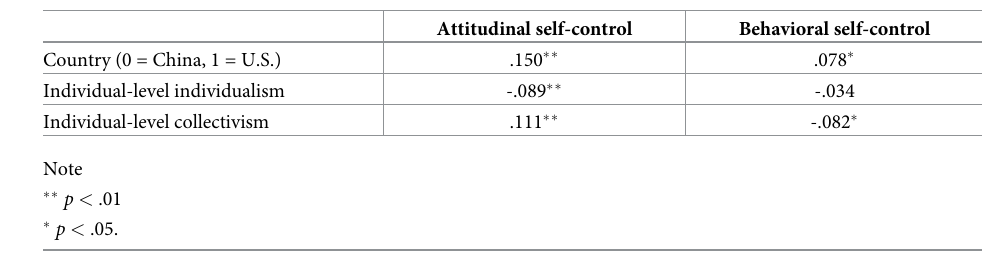
participants. Individual-level collectivism was negatively associated with behavioral self-con- trol but the one between individual-level individualism and behavioral self-control was not sig- nificant. This indicated that individuals’ collectivistic orientation was related to better